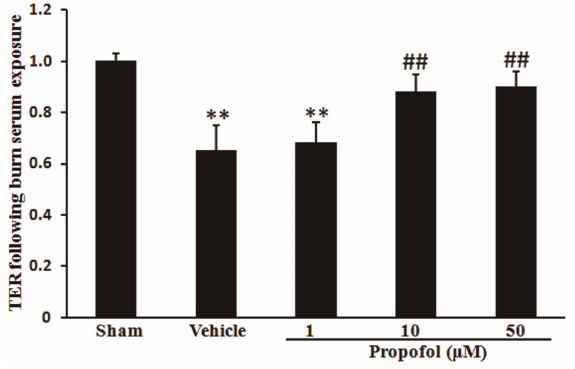
Figure 2. Effect of propofol on burn serum-induced monolayer hyperpermeability. Burn serum significantly increased monolayer permeability compared with sham serum-treated cells. Monolayer permeability was reflected by transendothelial electrical resis- tance (TER). Compared with burn serum-treated cells, propofol (10 and 50 m M) pretreatment maintained permeability at near- sham levels. Data are reported as means±SD (n=5 in each group). **P , 0.01, compared to the sham group; ## P , 0.01 compared to the vehicle group (one-way